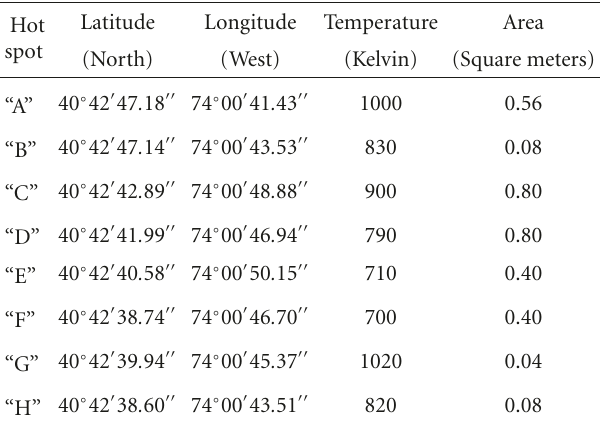
Table 1: Properties of the thermal hot spots reported in the rightmost part of Figure